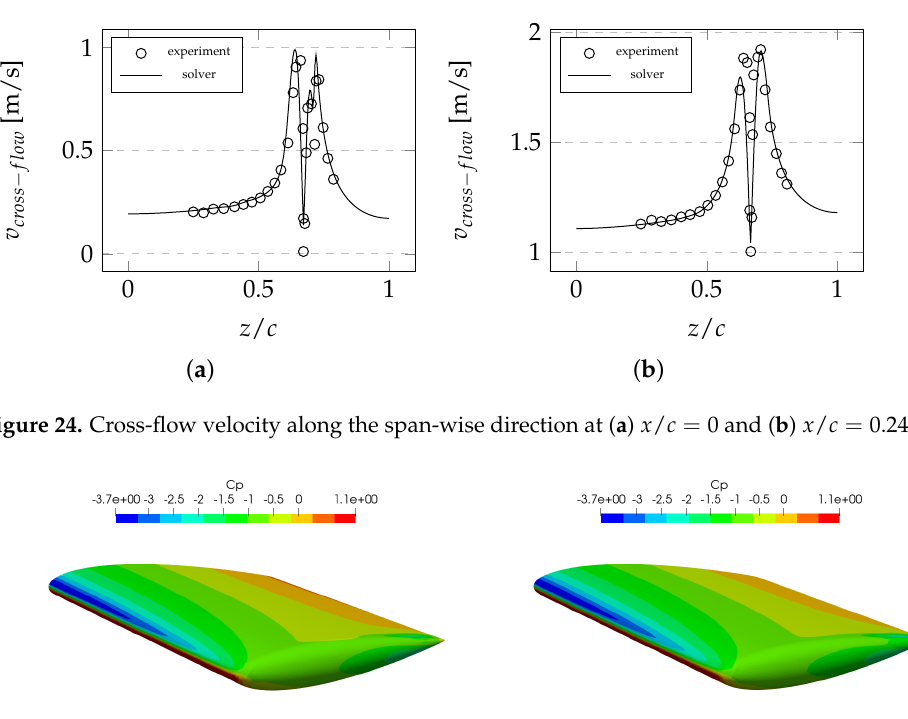
(b) Figure 26. (a) ONERA wing configuration and (b) sample mesh 0 u v w p T Figure 27. Convergence characteristics of flow equations